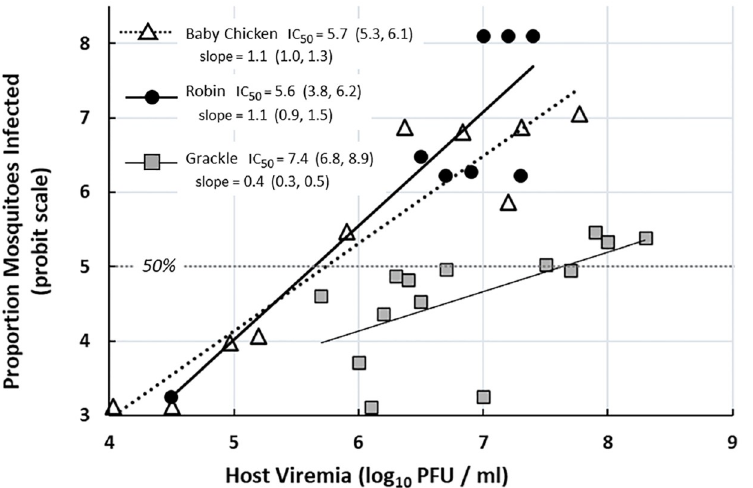
Fig 2. Dose-response (log-probit scale) of Culex pipiens mosquitoes to ingested West Nile virus when fed on viremic baby chickens, American robins, and common grackles. The IC 50 (95% confidence) values represent the predicted host viremia (log 10 PFU/mL) that infects 50% of the mosquitoes. Data for baby chickens were taken from references 26–28.